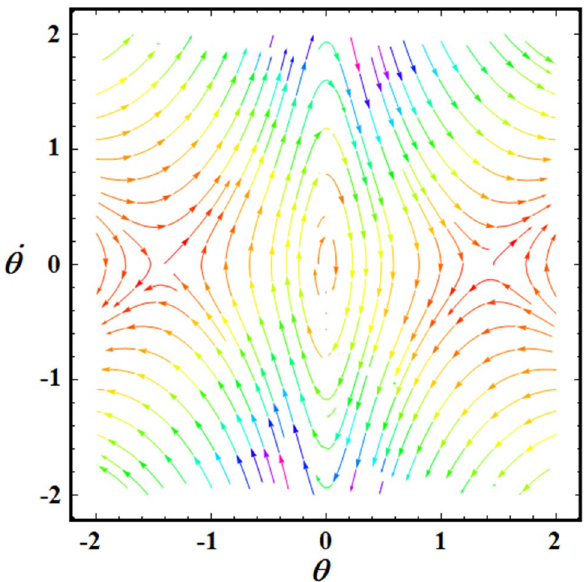
Figure 6. Depicts the phase portrait at L = 1 .